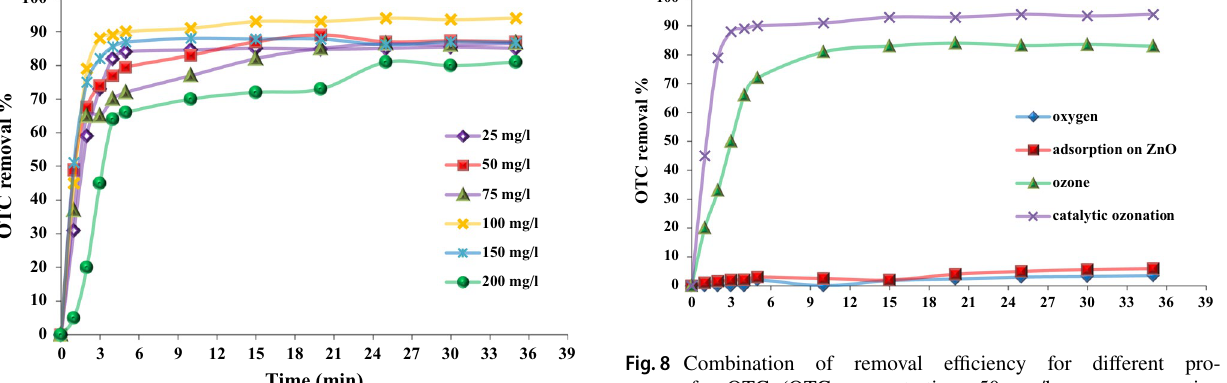
Fig. 8 Combination of removal efficiency for different pro- cesses for OTC (OTC concentration = 50 mg/l, ozone generation rate = 1.38 mg/s, at room temp.)